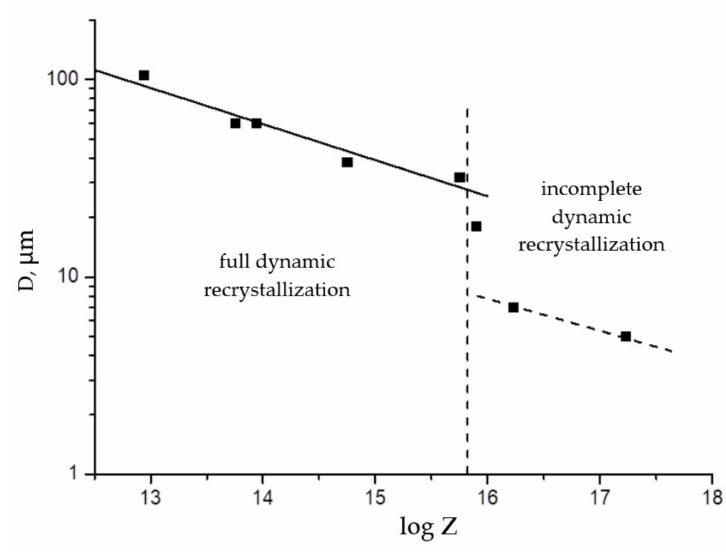
Figure 7. Recrystallized grain size as a function of the Zener–Hollomon